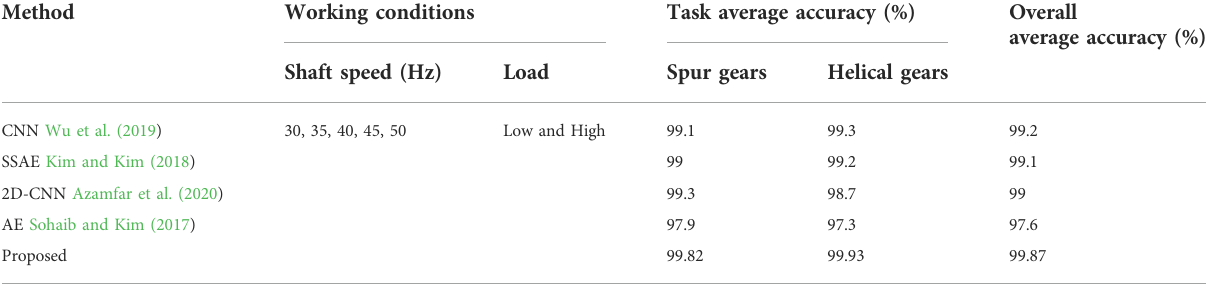
TABLE 4 The comparison results of state-of-the-art and proposed